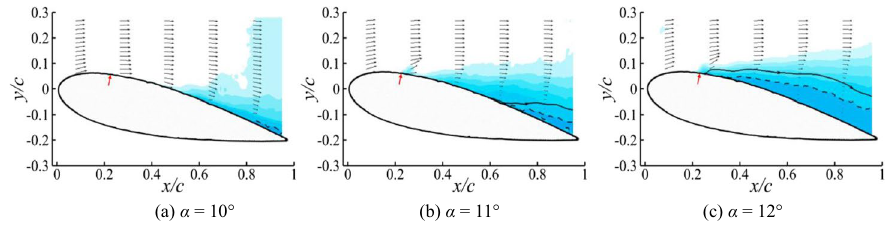
Fig. 15 Flow field velocity contours under conventional actuation for different jet orifice